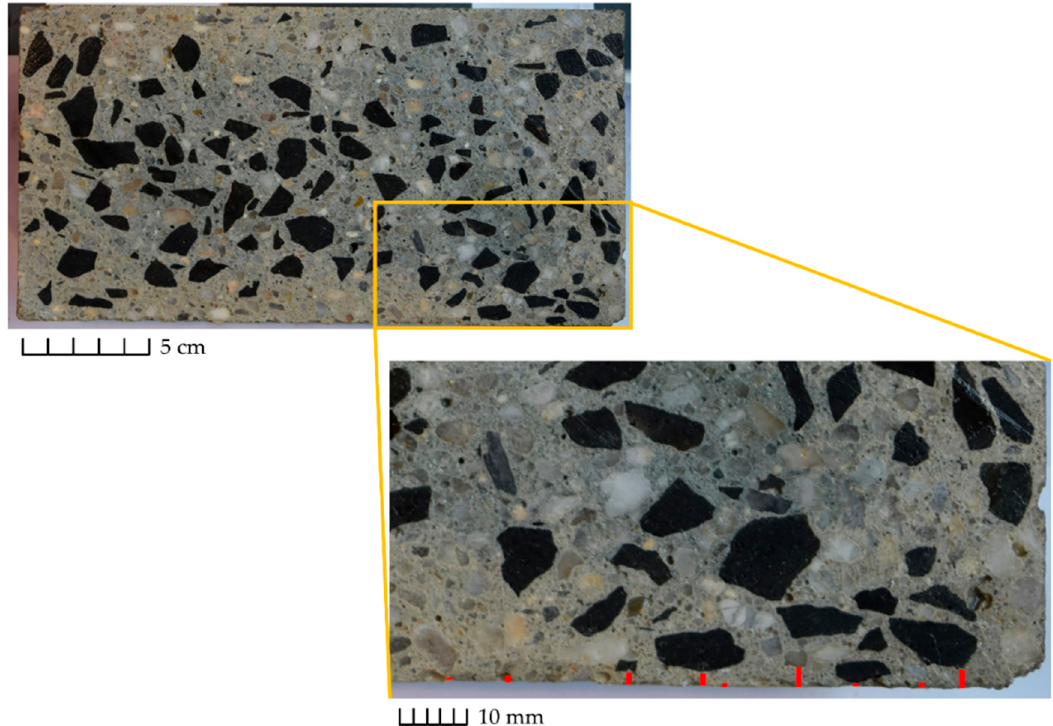
Figure 5. Determination of the lubricating layer thickness for C47c.